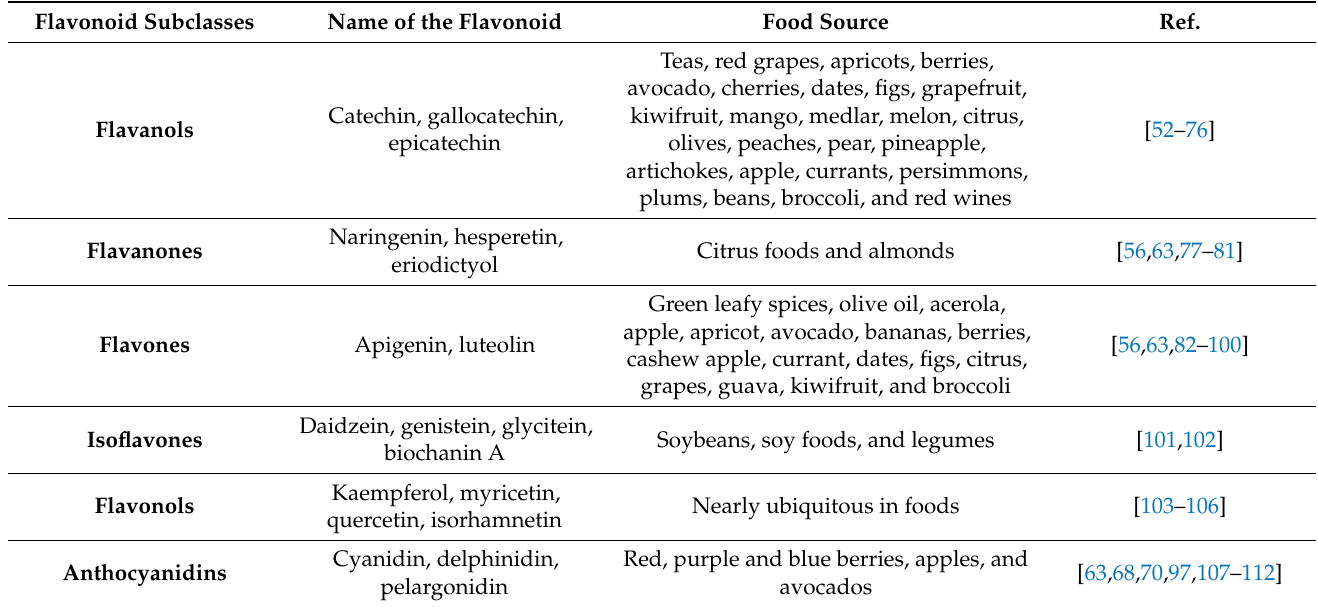
Table 1. Subclasses, prominent food flavonoids, and common food